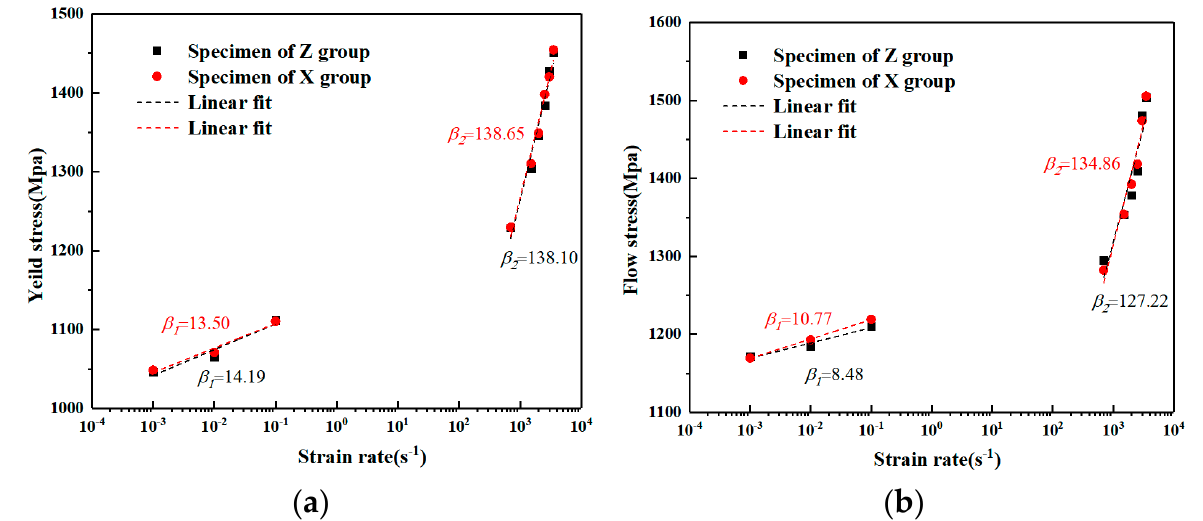
Figure 12. Strain rate sensitivity of yield and flow stresses under different loading conditions. ( a ) Yield strength. ( b ) Flow stress at an equivalent plastic strain of 0.05.